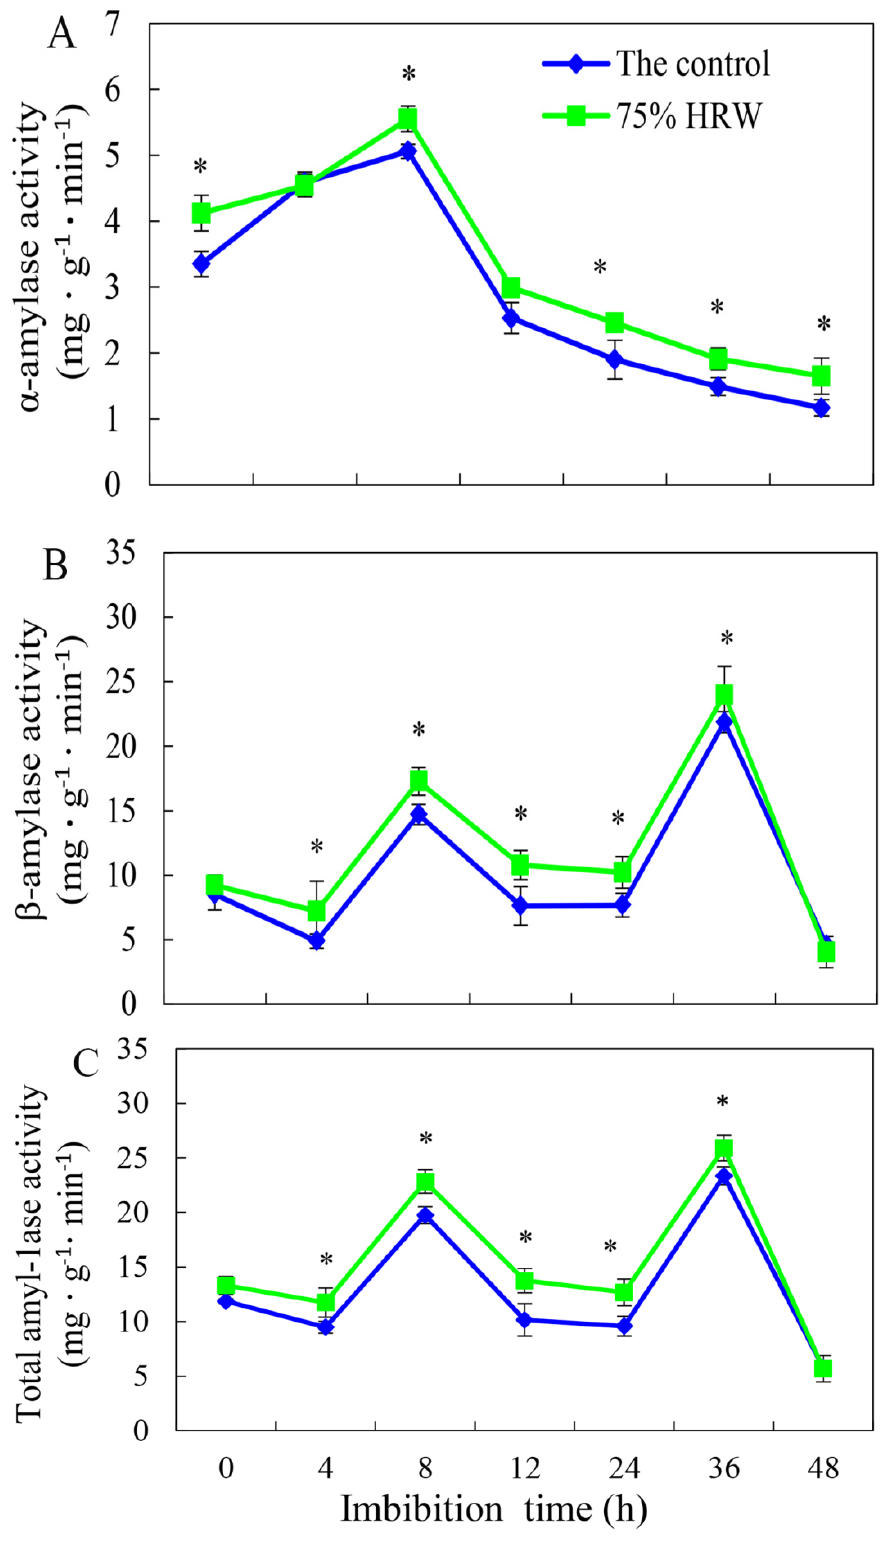
Figure 4. Changes in enzyme activities in cucumber seed with or without 75% HRW treatment dur- ing imbibition at 0, 4, 8, 12, 24, 36, and 48 h. ( A ) α -amylase activity, ( B ) β -amylase activity, and ( C ) Total amylase activity. Data are mean ± SE of three independent experiments. The asterisks denote Turkey–Kramer’s t -test significance under different treatments at the same time: * p < 0.05, h: hours, HRW: hydrogen-rich water.